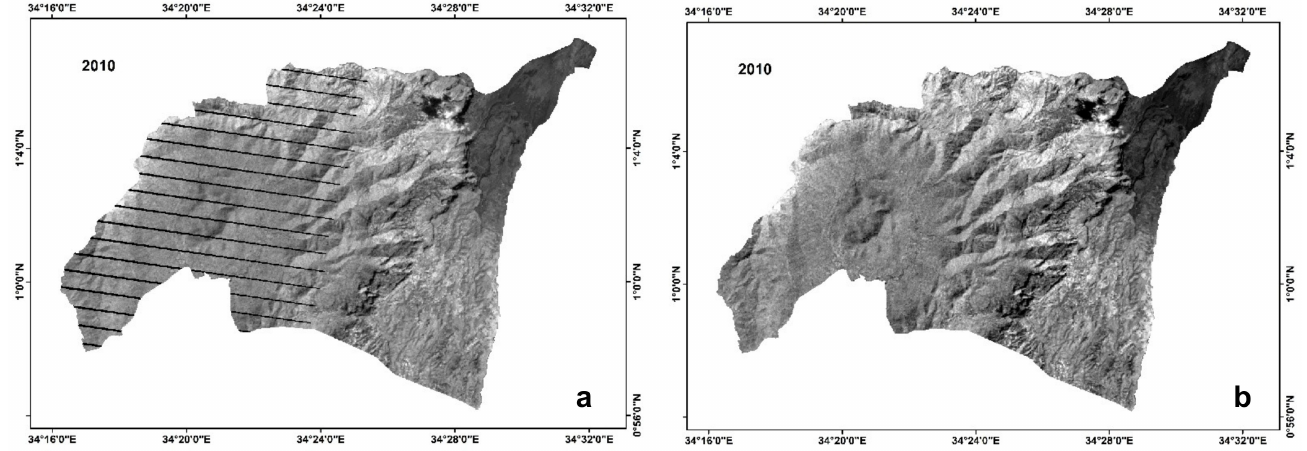
Figure 4. A view of the scan line corrector (SLC) failure of Landsat 7 image acquired in 2010: ( a ) SLC-Off and ( b ) SLC-Off